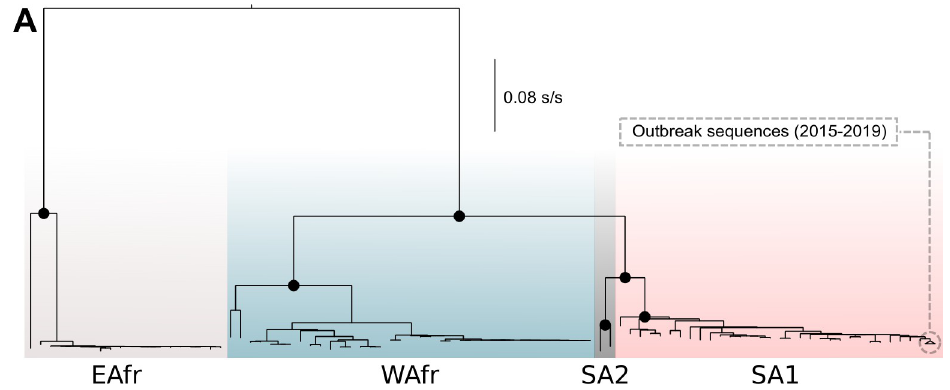
Fig 3. Maximum likelihood phylogenetic trees for YFV based on full-length polyprotein sequences (n = 264) indicate that the sequences associated with the outbreak in Brazil between 2016–2019 grouped within the genotype South American I. The tree is midpoint-rooted and the black circles on the main nodes represent bootstrap support values greater than 0.7. The distinct colors represent distinct genotypes: ( i ) EAfr—East African; ( ii ) WAfr—